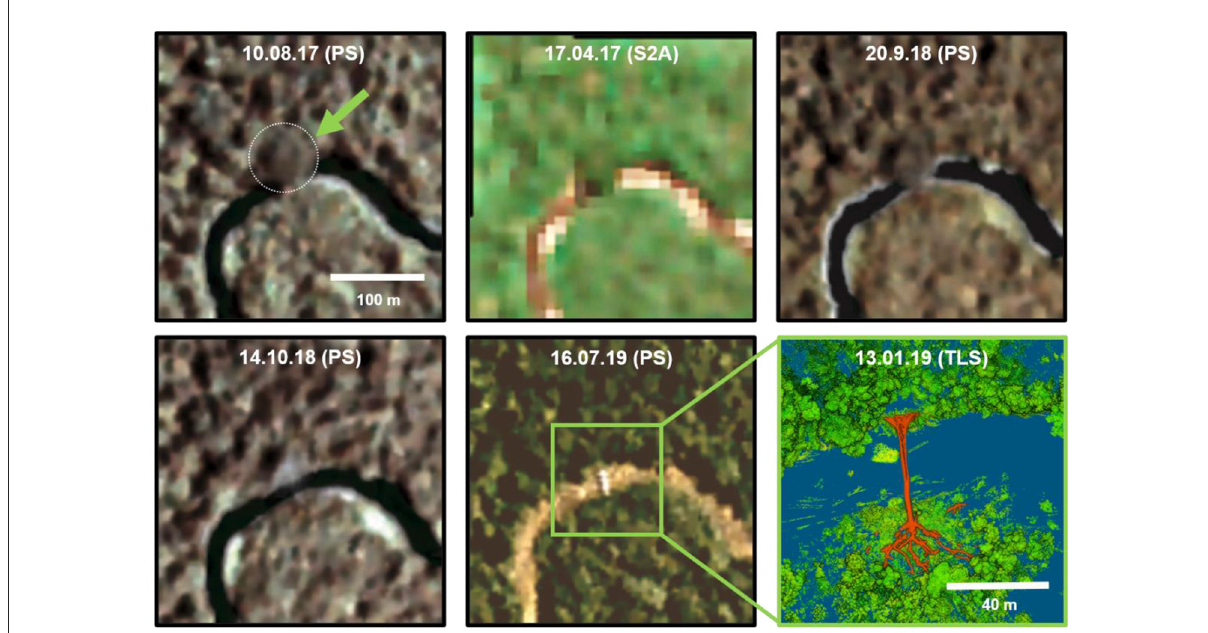
FIGURE3 Spaceborne observation of a standing/fallen large Ceiba pentandra tree. Satellite images were taken from PlanetScope (PS) and Sentinel-2 (S2A) archives. Images contrast was improved for visibility. On 13 Jan 2019 the location (7.678120 ◦ N, 77.833020 ◦ W) was visited and scanned using TLS (lower right scene). The tree structure is delineated by orange color. Tree height (in the fallen state) was estimated to be > 60m, crown base height at ∼ 40m, and DBH above the buttress at